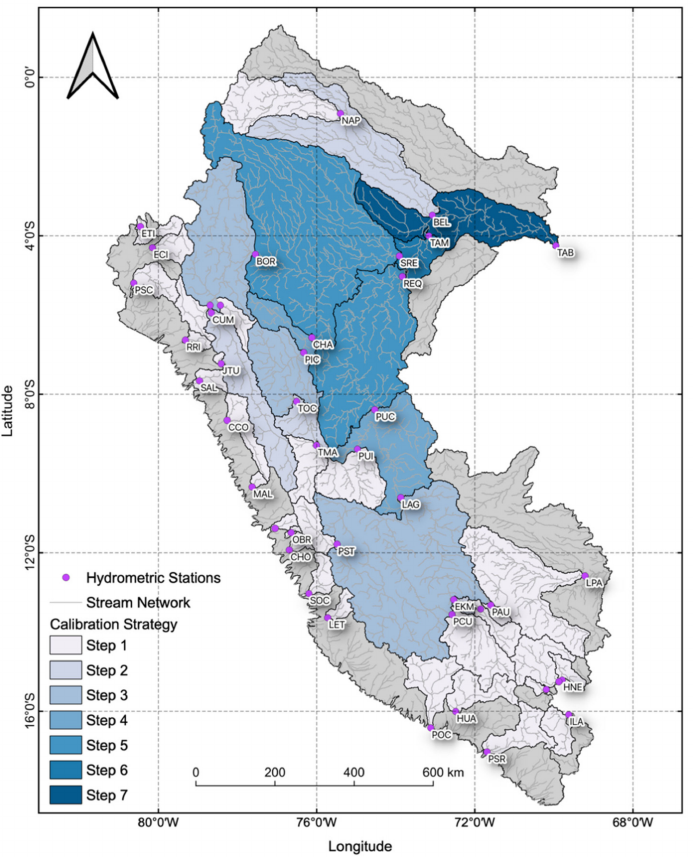
Figure 4. Strategy for the GR2M model calibration at a national level. Steps are based on the stream network configuration and location of the hydrometric stations in gauged areas. Each basin might contain more than one set of X1 and X2 parameters. Gray areas correspond to ungauged